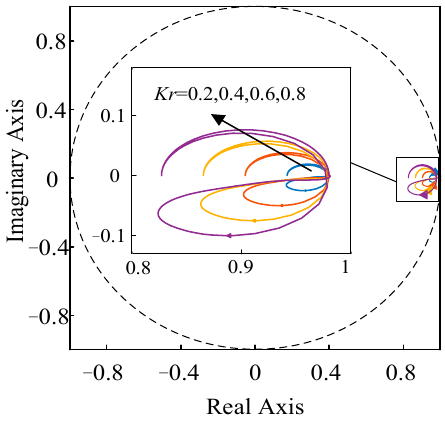
Figure 9. Trajectory of G F ( e jwTs ) with different k r.